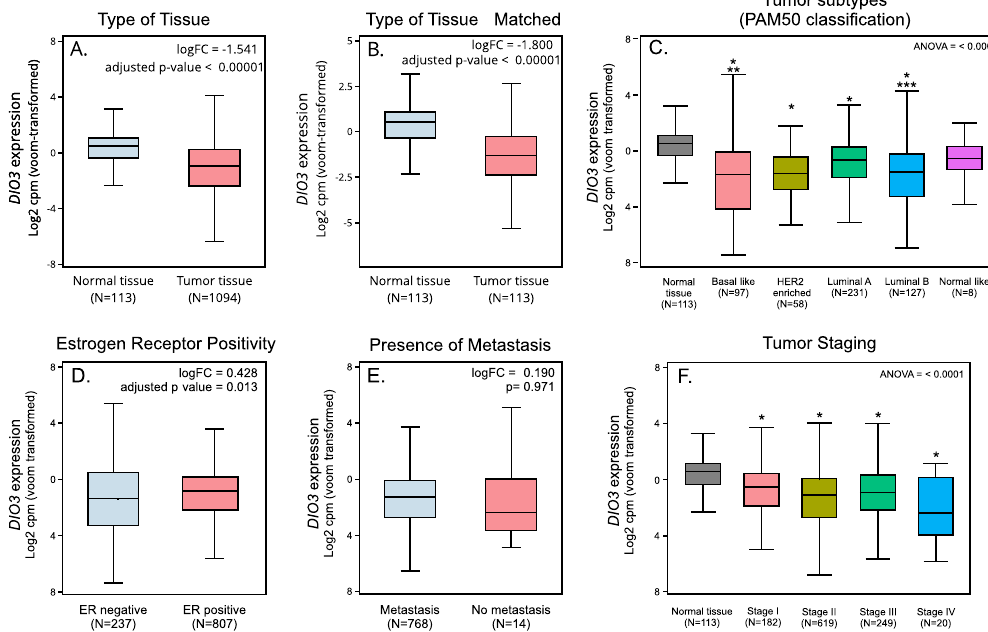
Figure 3. The relationship between DIO3 mRNA expression and clinicopathological parameters in breast cancer samples of patients from the TCGA-BRCA cohort expressed in Log2 counts per million ( voom - transformed). Comparative expression demonstrates that DIO3 mRNA is decreased in tumoral tissue when compared to normal tissue when analyzing ( A ) all samples or ( B ) only matched samples. ( C ) All tumor subtypes have decreased expression of DIO3 mRNA when compared to normal tissue, with the exception of normal-like tumors compared to normal tissue. DIO3 mRNA levels were also reduced in basal-like tumors when compared to luminal A (**) (logFC = -1.024; adjusted P value = 0.0003) and in luminal B when compared to luminal A subtypes (***) (logFC = -0.915 adjusted P value = 0.0009), and ( D ) DIO3 expression is increased in ER-positive samples when compared to ER-negative samples. ( E ) DIO3 expression is similar in patients with or without metastasis. ( F ) When samples were separated according to tumor staging, all tumor stages had decreased DIO3 expression when compared to normal tissue, but there was no difference in expression between the stages. ER estrogen receptor. *Adjusted P value < 0.0001 in comparison to normal tissue.